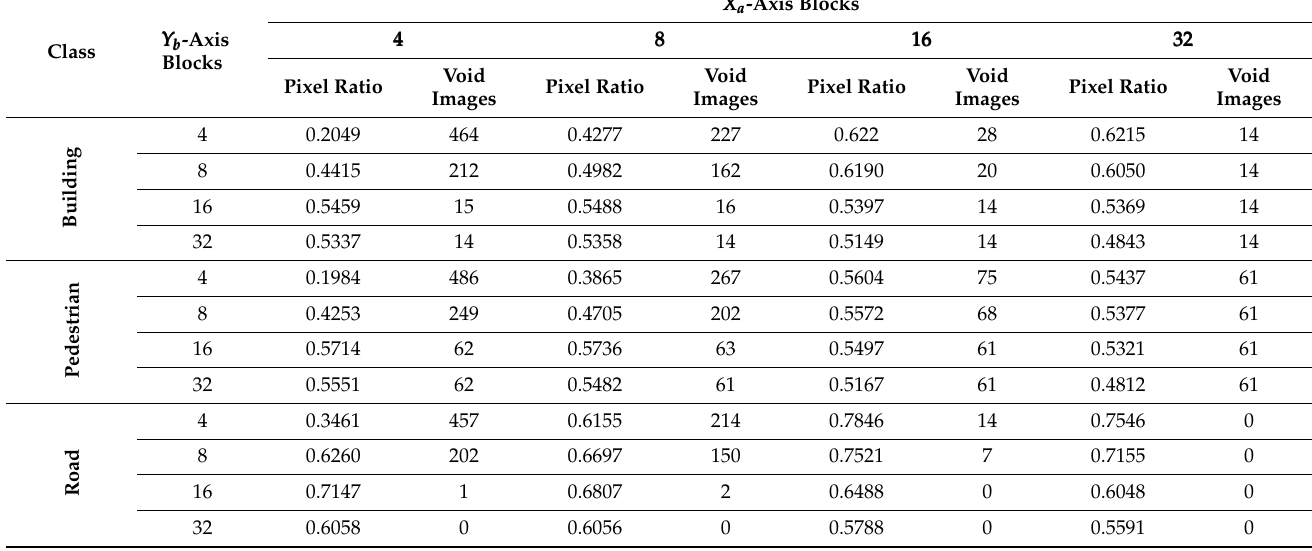
Table 2. Analysis of segmented image categories for